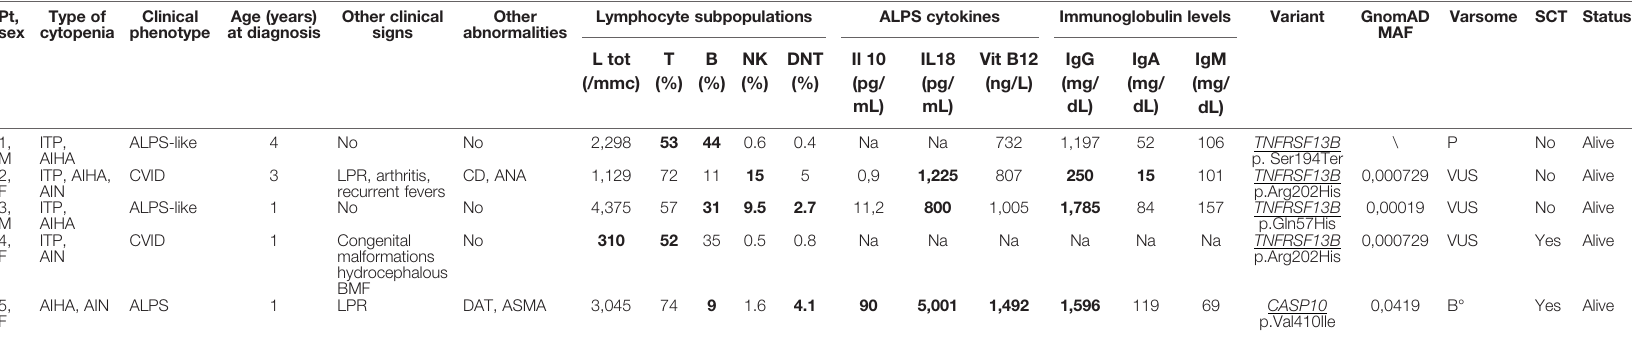
TABLE 3 | Clinical/immunological characteristics of patients carrying pathogenic or of unknown signi fi cance variants related to risk factors for immune-dysregulation (abnormal results in bold). Pt, Type of sex